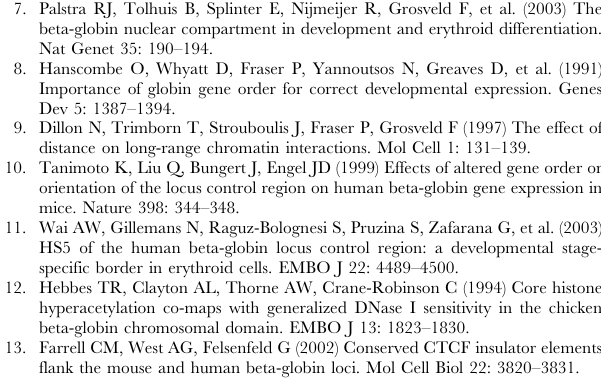
Figure S1 Alignment of the cHS4 CTCF binding site with the b m promoter. Alignment of the cHS4 CTCF binding site with the b m promoter (1). The b m gene cap site ( + 1) are indicated with a blue